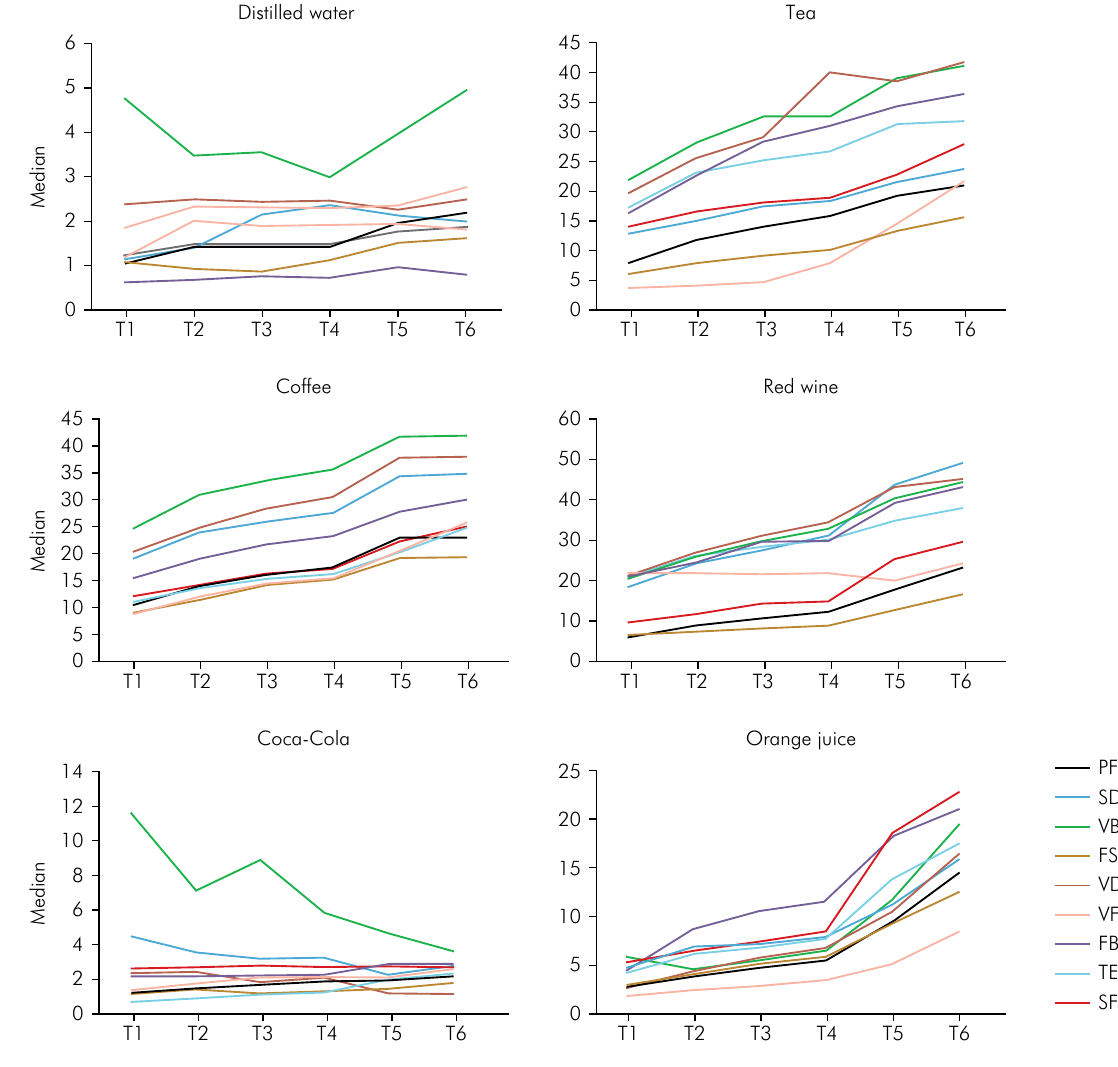
Figure. Color change progression of each composite and staining solution at the different time